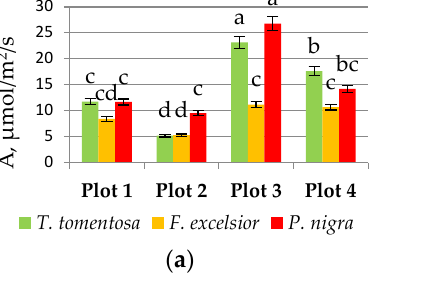
Figure 5. Bi-plot graph resulting from principal component analysis (PCA) illustrating the correla- tion between measured variables (leaf traits, photosynthesis, stomatal conductance, and transpira- tion) and urbanization intensity. 3.4. Molecular Traits Molecular analyses of newly planted saplings of T. tomentosa , F. excelsior, and P. nigra were performed once per year in the period from 2015 (the initial year of planting in the urban area) up to 2020 (6 years after planting in the urban environment). First molecular traits in the studied genetic pro fi les were observed after the 5th year, but they were not very well expressed. Be tt er results were obtained during the next year (2020), and they are presented and discussed here.